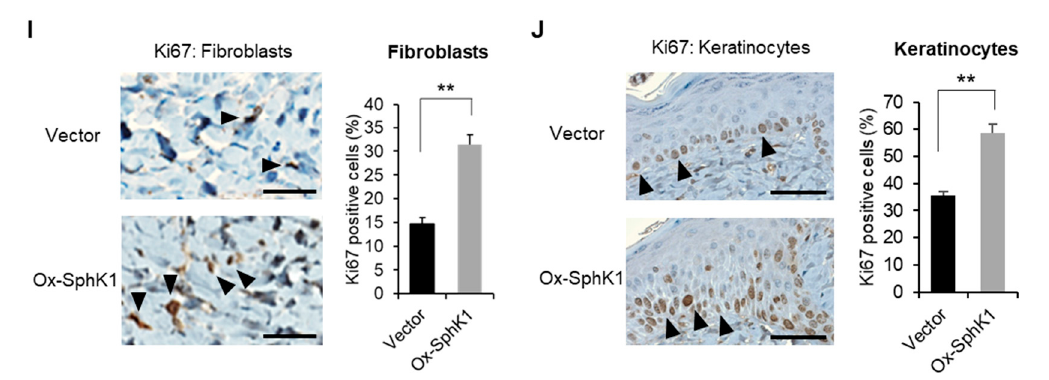
Figure 4. E ff ect of SphK1 overexpression on wound healing, vasculogenesis, and cell proliferation. ( A ) In vitro transfection e ffi ciency with SphK1-expressing plasmid using super carbonate apatite (sCA) in NIH3T3 cells. ( B ) An ointment containing a SphK1-expressing plasmid encapsulated with sCA was prepared. ( C ) In vivo transfection e ffi ciency of the sCA-encapsulated plasmid, as shown by immunoblots of V5-SphK1 expression in the wound surface tissues two days after application. ( D ) Representative images of the closing wounds are shown. ( E ) E ff ect of the plasmid ointment on wound closure. The change in wound area over time is graphed ( n = 12). ( F ) Representative images of CD34 expression on immunohistochemistry are shown. Arrowheads indicate positive findings (scale bars: 50 µ m). ( G ) The numbers of CD34-positive microvessels per 200-fold magnified field are graphed ( n = 4). ( H ) The percentage of the wound area that is occupied by CD34 + cells is graphed ( n = 4). ( I ) Representative images of Ki67 expression in fibroblasts on immunohistochemistry are shown. Arrowheads indicate positive findings (scale bars: 50 µ m). The frequencies of Ki67 + fibroblasts are graphed ( n = 4). ( J ) Representative images of Ki67 expression in keratinocytes on immunohistochemistry are shown. Arrowheads indicate positive findings (scale bars: 50 µ m). The frequencies of Ki67 + keratinocytes are graphed ( n = 4). All values shown in this figure represent the mean ± s.e.m. * p < 0.05, ** p <